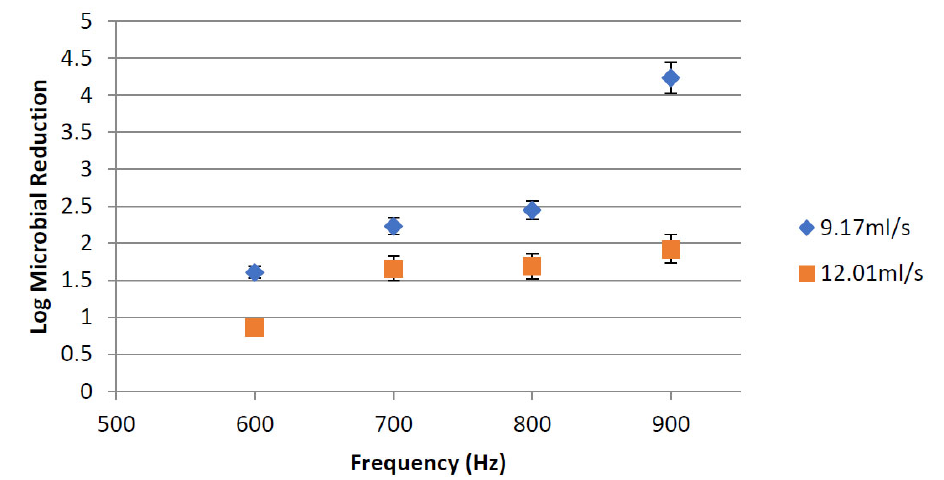
Figure 6. The effect of different flow rates and frequencies for a field intensity of 25 kV/cm on the E. coli population suspended in diluted protein shake drink.